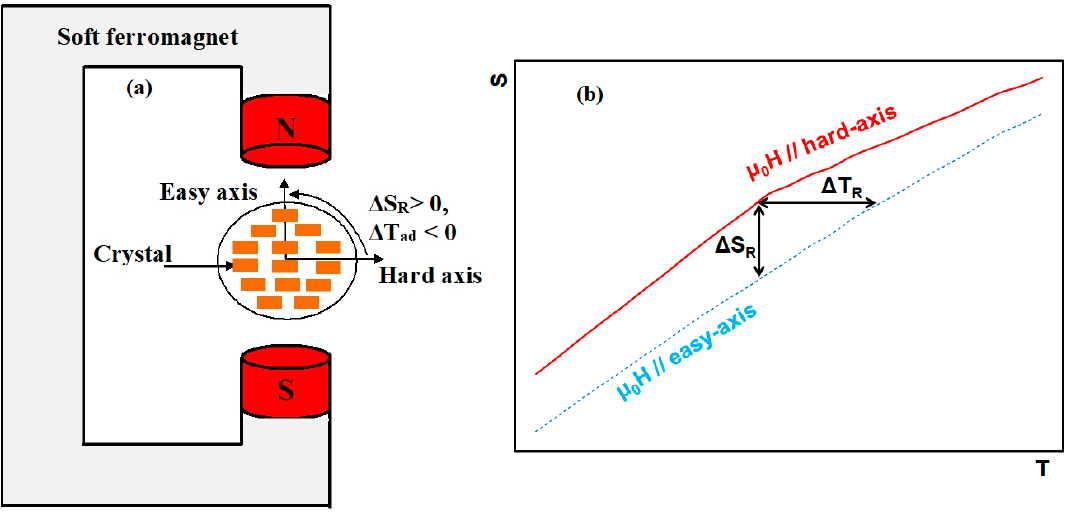
Figure 1. ( a ) Generation of the MCE by rotating the single crystals between their easy and hard-axes; ( b ) Full entropy as a function of temperature along the easy and hard-axes. ( b ) Full entropy as a function of temperature along the easy and